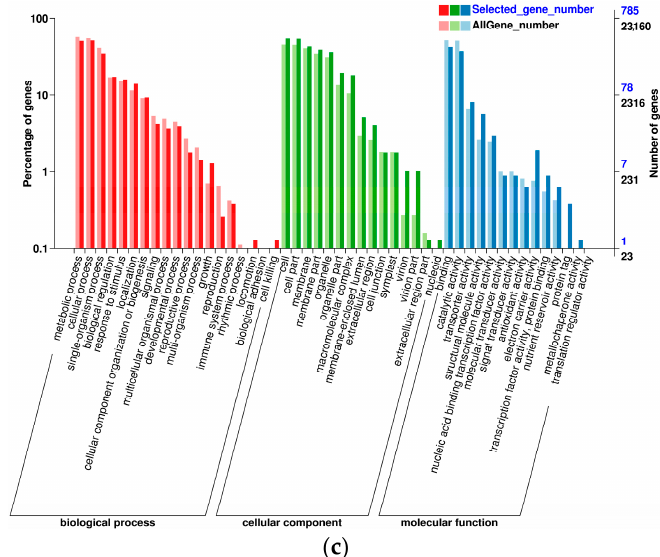
Figure 6. Number and Gene Ontology (GO) classification enrichment of differentially expressed genes (DEGs) among the different E-L 35, E-L 36, and E-L 38 stages, respectively ( a – c ). The DEGs were assigned into three classifications of the cellular components, molecular function, and biological process.